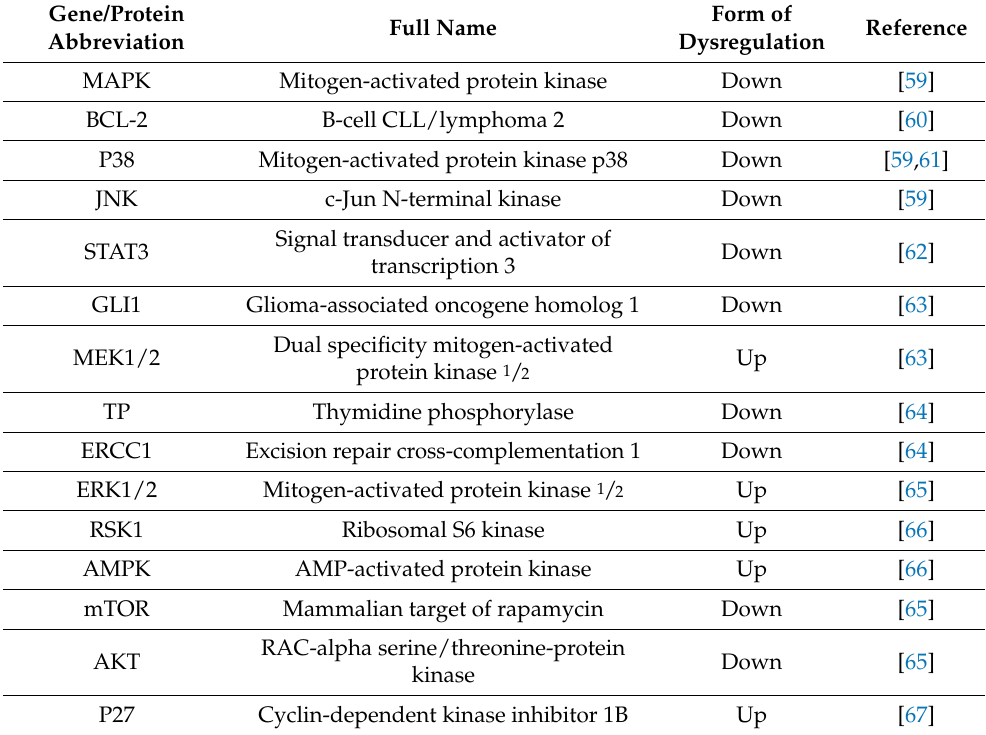
Table 1. Metformin’s metabolic